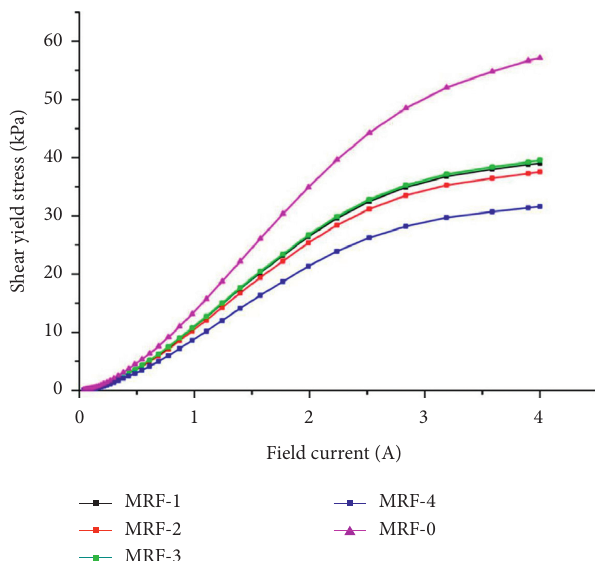
Figure 13: Shear yield stress curves before and after wear experiments.